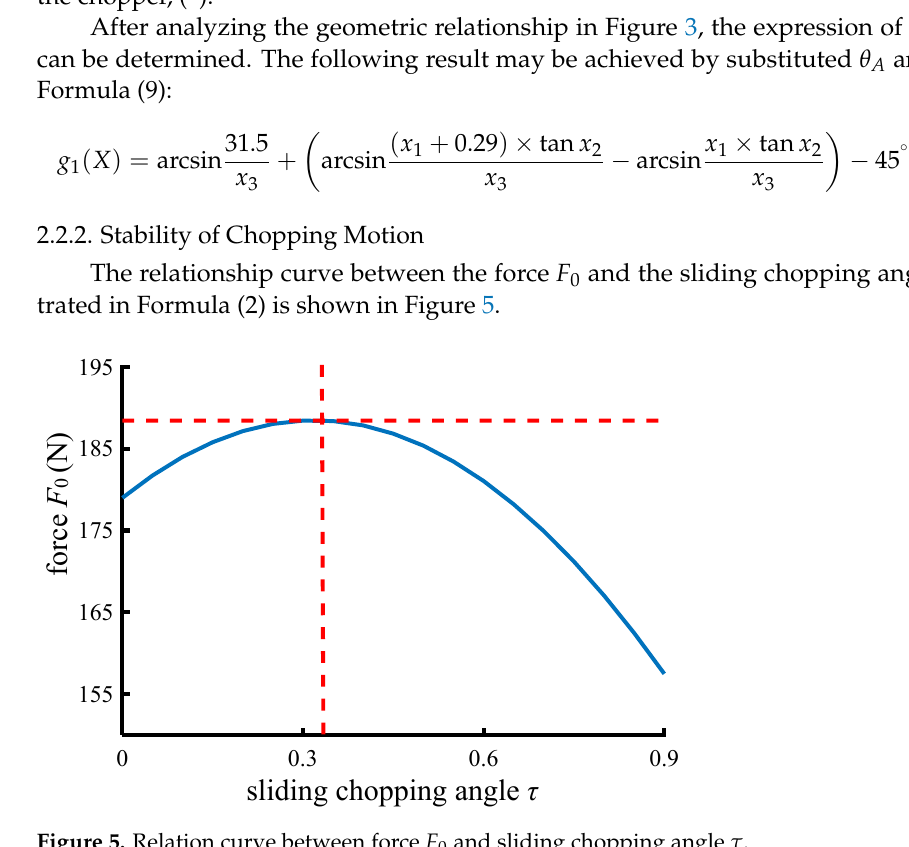
Figure 5. Relation curve between force F 0 and sliding chopping angle τ .